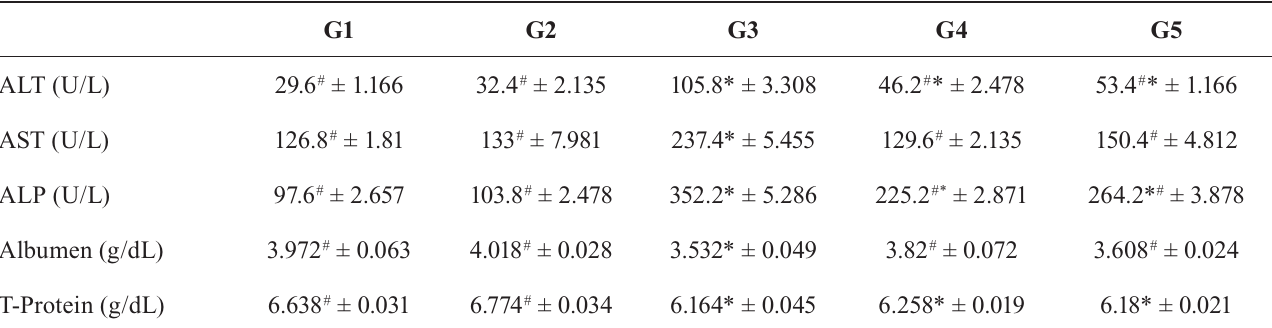
TABLE I - C hanges in liver functions in different